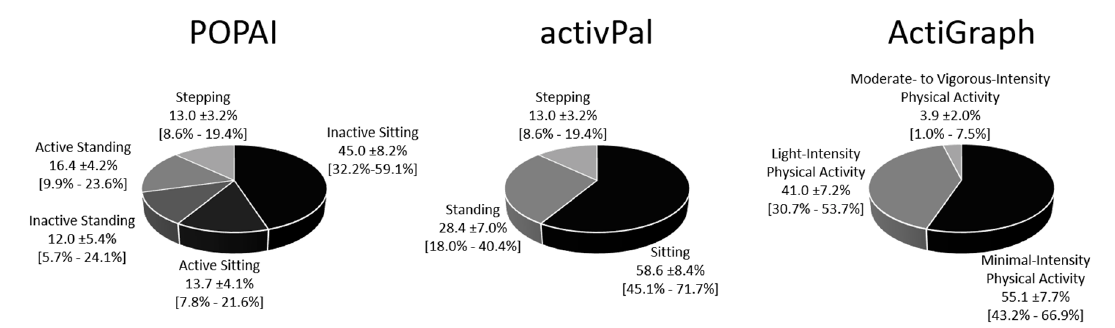
Figure 3. Daily wake time use for each method. Indicated is the mean ± standard deviation [5th to 95th percentile] in percentage of waking hours (100% equals 15.0 h) for each behavior and method, n = 100.